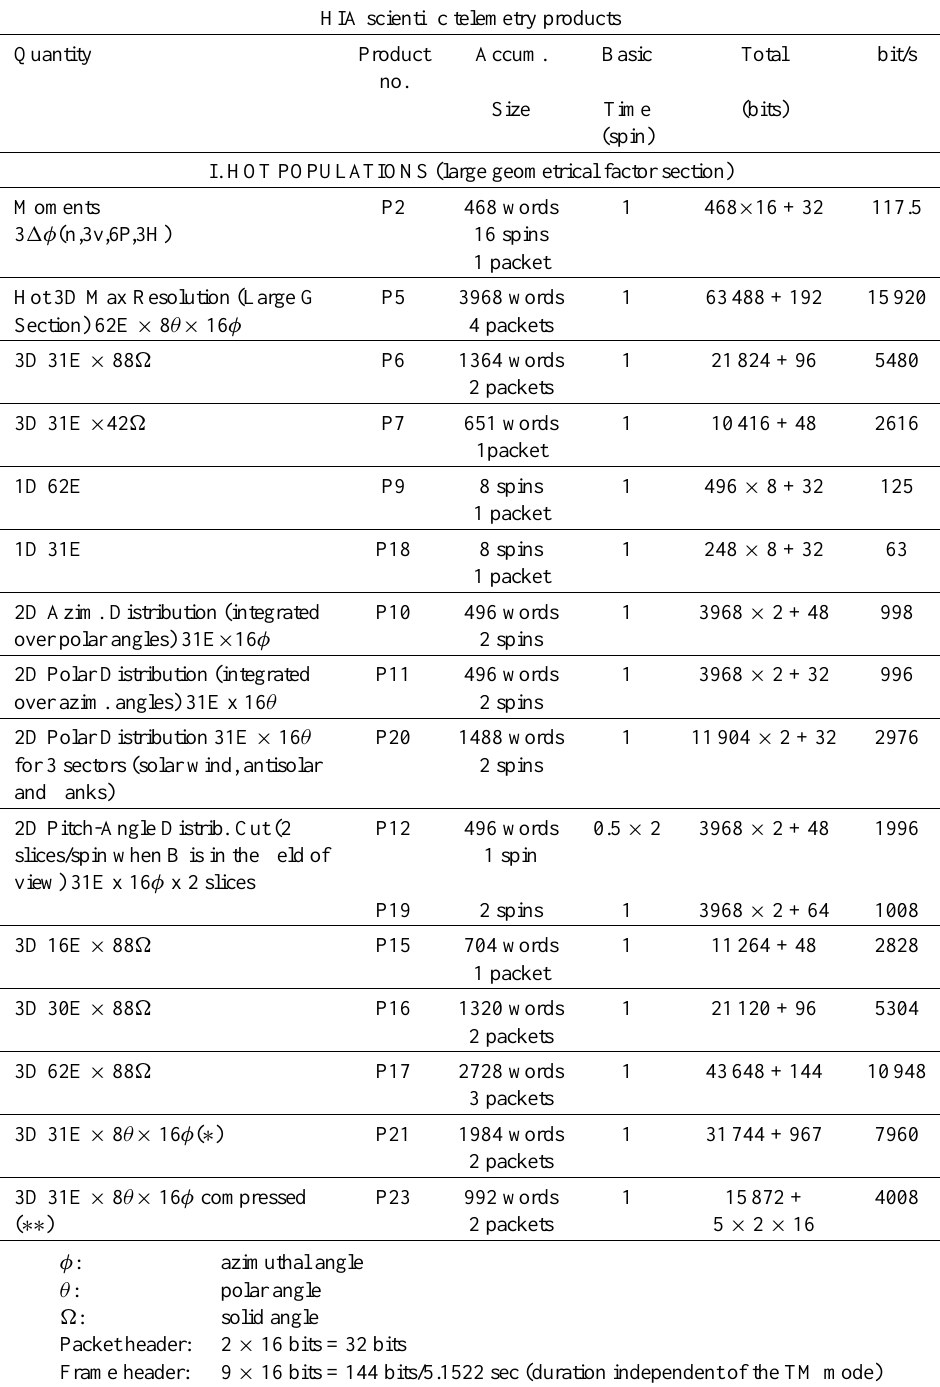
Table 5. HIA scientific telemetry